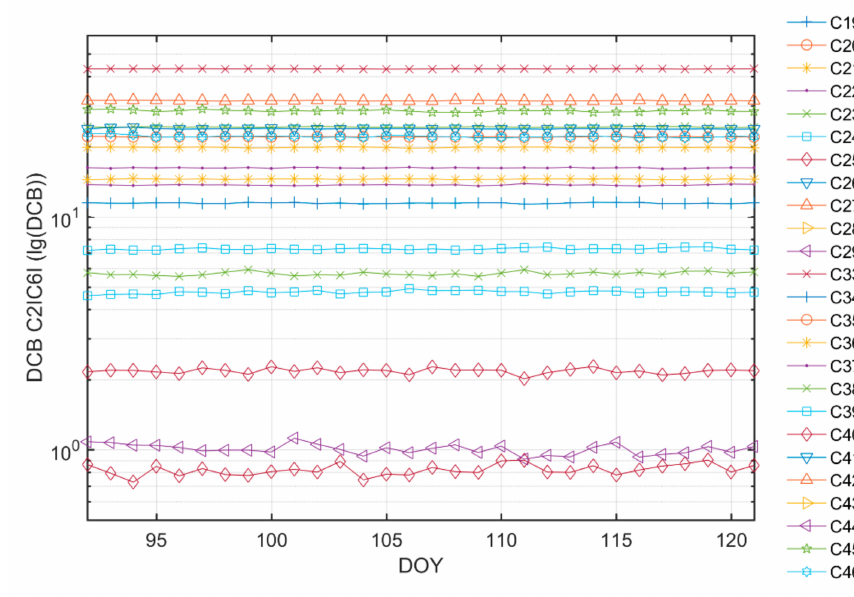
Figure 1. Time series of daily DCB C 2 I _ C 6 I (lg ( DCB B 1 I − B 3 I ) ).